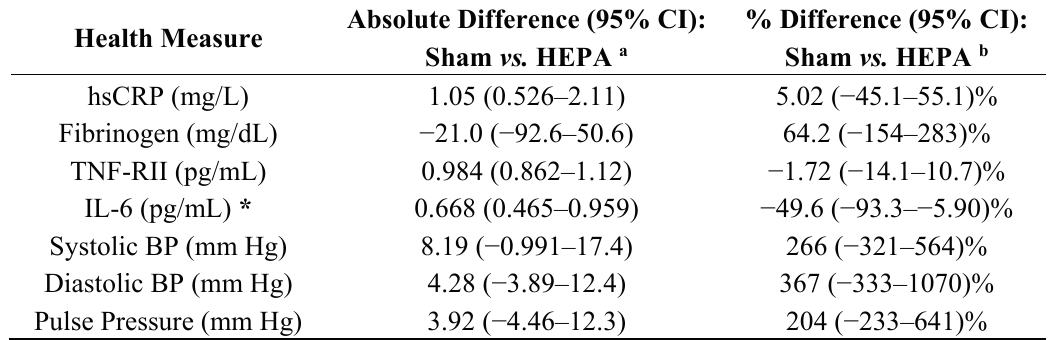
Table 3. Differences in change in blood biomarker and blood pressure measurements due to